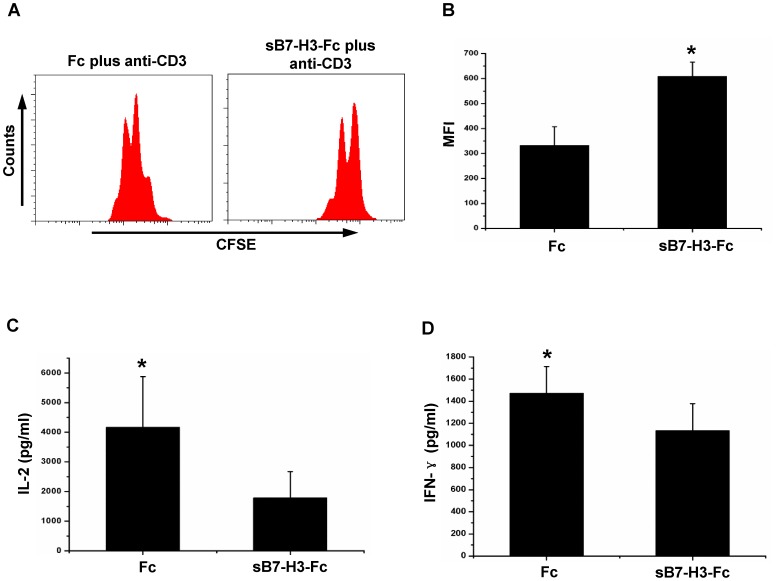
Functional analysis of spliced sB7-H3 on T cell response.CFSE-labeled purified T cells were seeded to a 96-well flat-bottomed plate precoated with 1 µg/ml anti-human CD3 (OKT3), plus either 10 µg/ml spliced sB7-H3-Fc or Fc. After culturing for 72 h, T cell proliferation and cytokines in the culture supernatant was analyzed. A, A representative plot of T cell proliferation analyzed with FACS assay. B, Statistical analysis of the mean fluorescence intensity (MFI) on T cells (mean ± s.e.m). C and D, the concentration of IL-2 and IFN-γ in the culture supernatant was analyzed with multiplex kit and analyzed by FlowCytomixPro software. “*” indicated P<0.05.